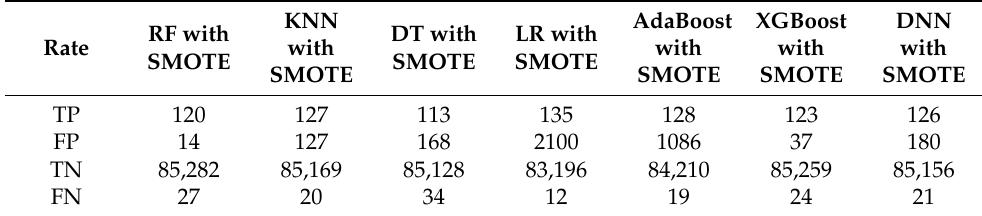
Table 10. TP, FP, TN, FN rates of machine learning algorithms with SMOTE based on resampling approach 2.